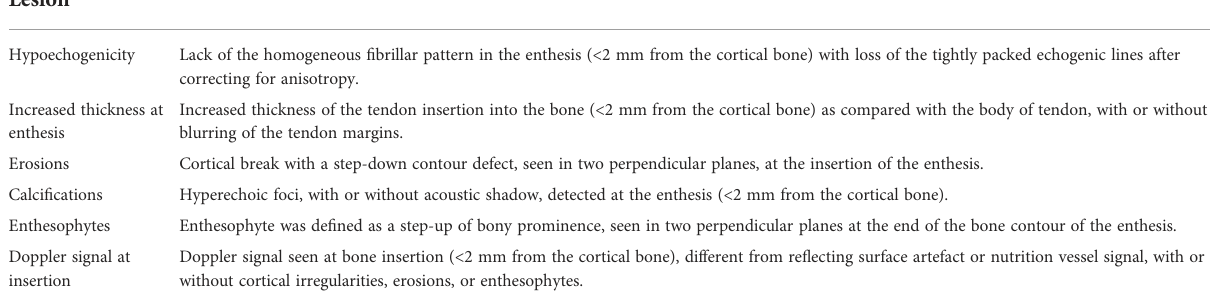
TABLE 3 OMERACT de fi nitions of elementary lesions of enthesitis upon ultrasound examinations. Elementary